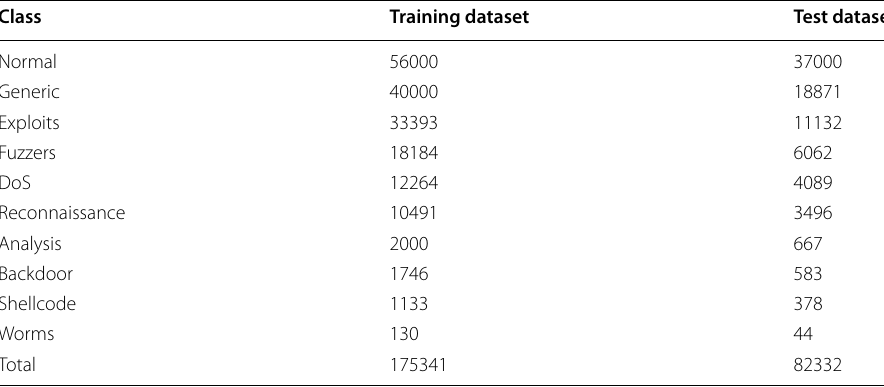
Table 2 Records of 10% UNSW‑NB15